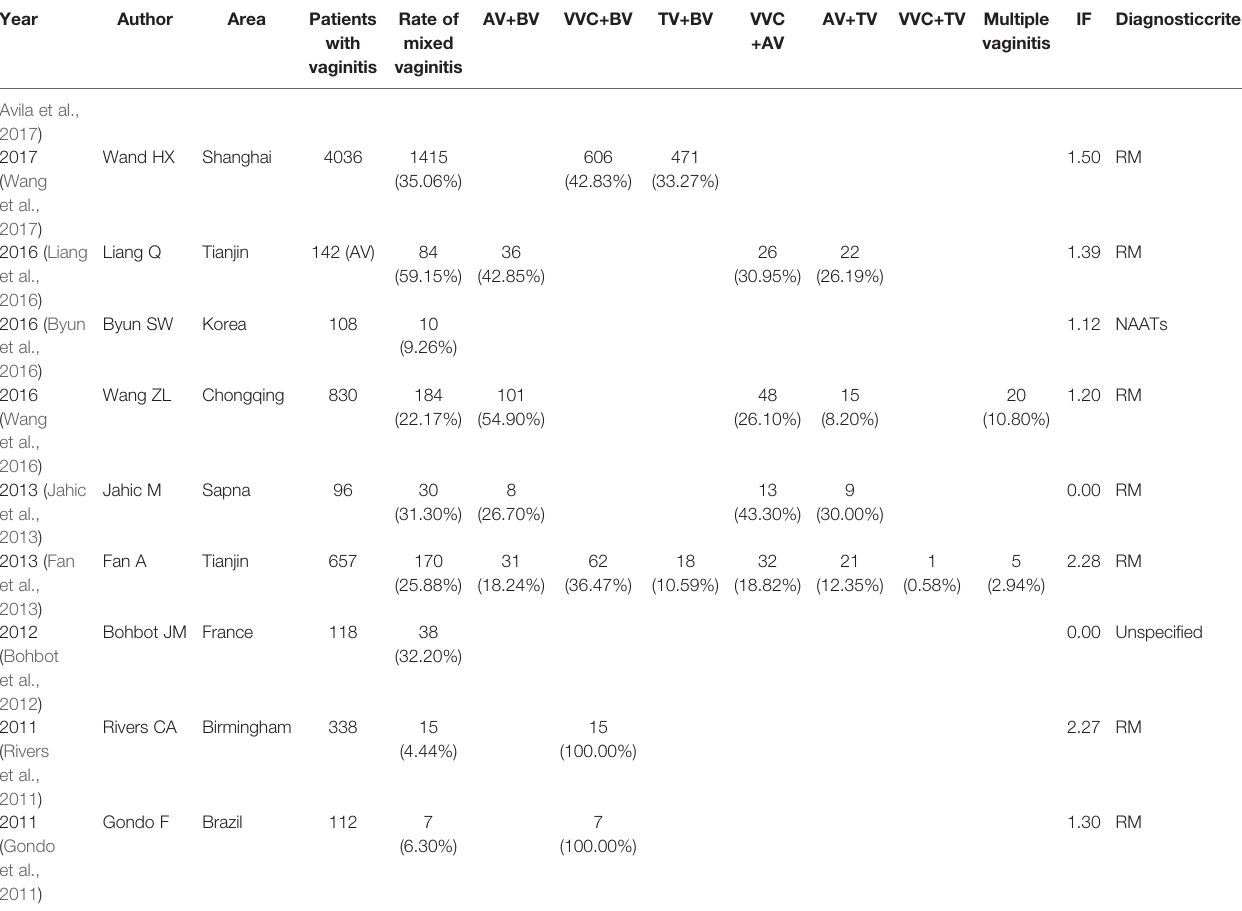
① The “ patients with vaginitis “ in column 4 refers to the women having a laboratory-diagnosed cause of vaginitis; “ 250 (RVVC) ” refers to 250 patients with RVVC; “ 29 (TV) ” refers to 29 patients with TV; “ 142 (AV) ” refers to 142 patients with AV; ② The “ rate of mixed vaginitis ” in column 5 refers to the ratio of mixed vaginitis to total vaginitis; ③ The rates in the following columns refer to the ratio of each item in mixed vaginitis; ④ The “ Diagnostic criteria ” in column 14 refers to RM and NAAT. RM: The reference methods for BV were Nugent ’ s score and Amsel ’ scriteria. Thereference methodsforVVCandTV were wetmountandculture. Thereference methodforAV was wetmountbasedon thecriterionby Donders. NAAT, Nucleicacid ampli fi